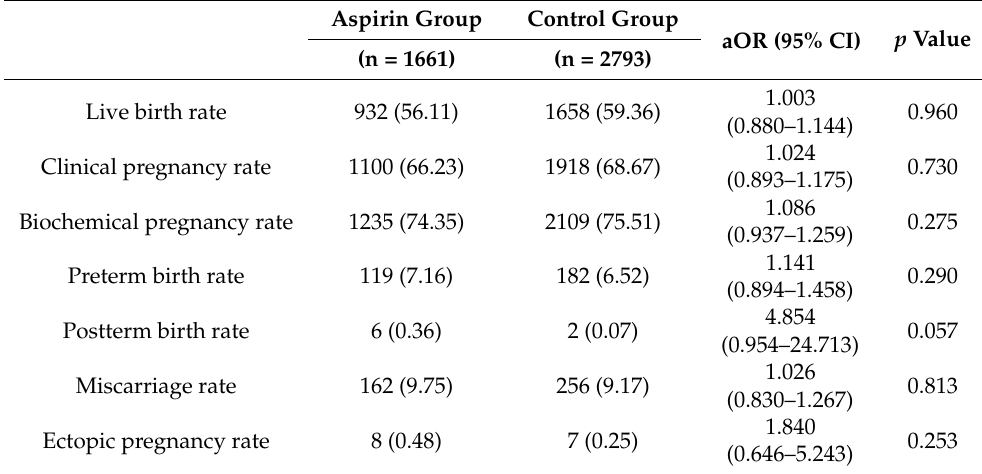
Table 2. Relationships between aspirin and pregnancy outcomes.